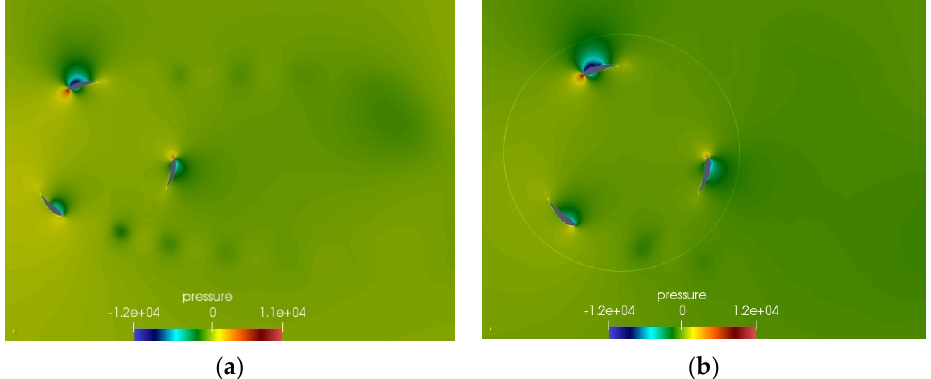
Figure 12. Instantaneous pressure field at TSR = 2 and azimuthal angle of 15 ◦ for ( a ) OM and ( b ) SM.